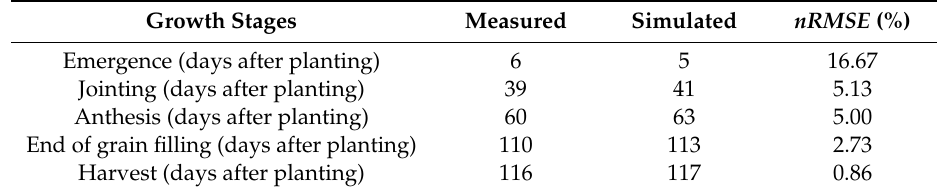
Table 5. Measured and simulated growing stage in 2017 using the calibrated cultivar coefficients.